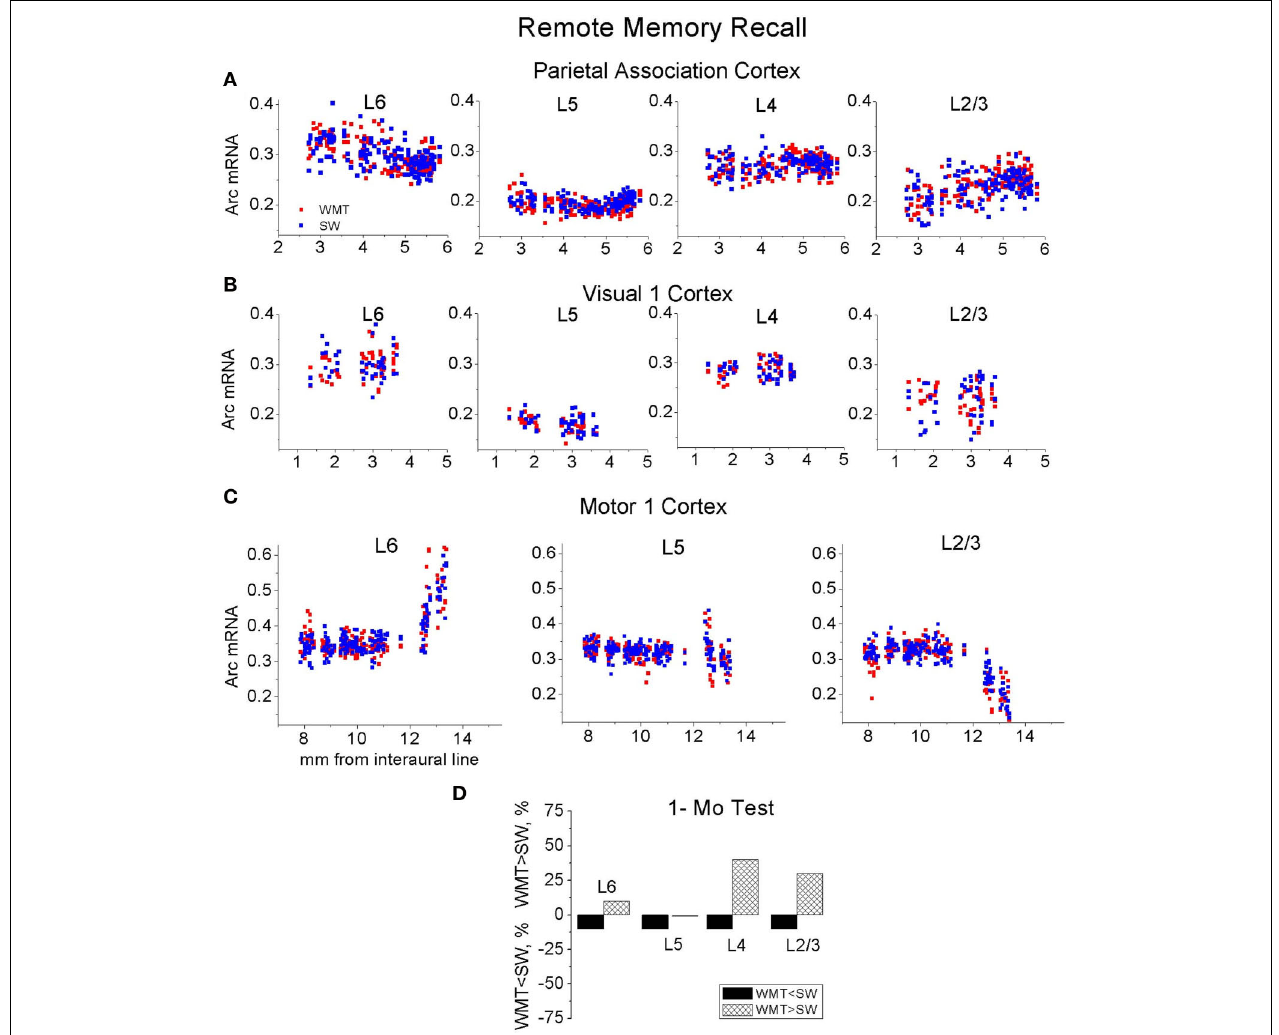
FIGURE 7 | The reorganized stereotypical pattern in Arc laminar redistribution appeared after remote WM recall. The probe tests on a WM task learned 1 month ago induced more frequent increases in Arc mRNA fractions in the upper layers L4 and L2/3 as compared to the lower layers. However the